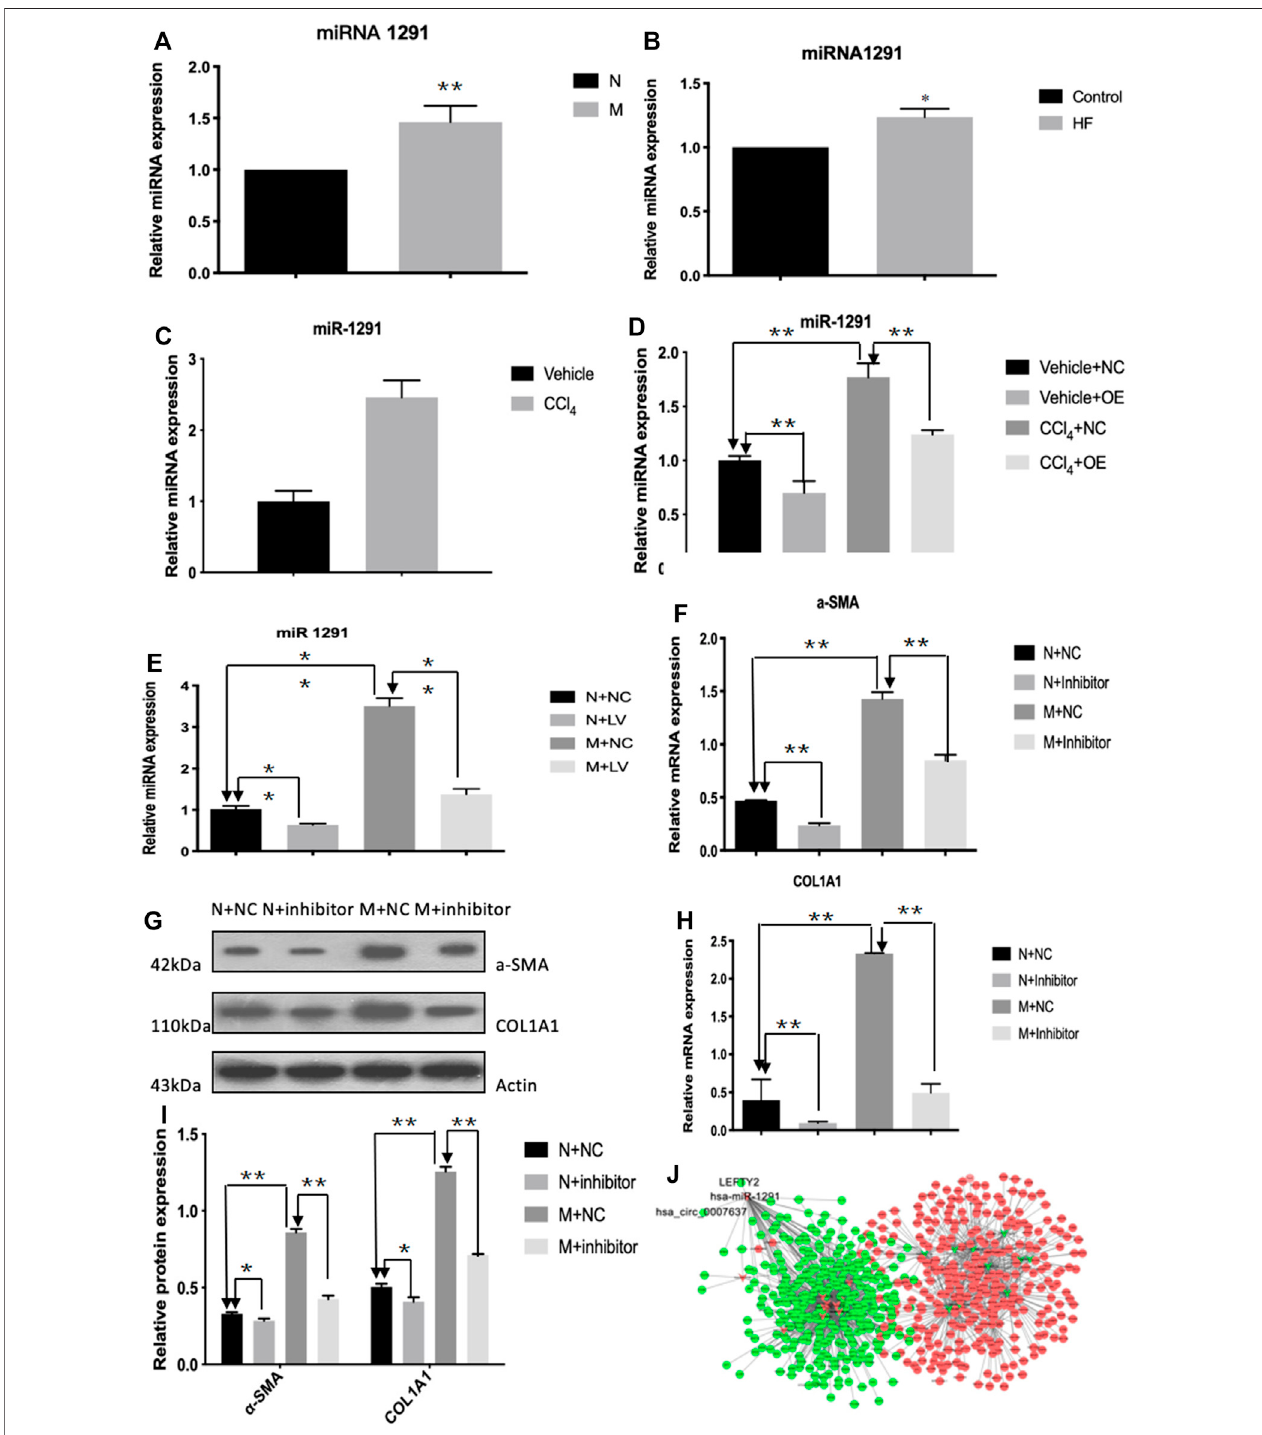
FIGURE 7 | CircCREBBP upregulates the expression of LEFTY2 by sponging hsa-miR-1291. The qRT-PCR results showed that the expression level of hsa-miR- 1291wereup-regulated inTGF- β 1-indcued LX-2cells, HFpatientsand mousetissues (A – C) .WhencircCREBBPexpression wasincreased,hsa-miR-1291 expression level was down-regulated (D,E) . α -SMA and Col1A1 protein and mRNA expression levels in LX-2 cells transfected with over-expressed hsa-miRNA-1291 were decreased (F – I) . An interaction network of circRNAs-miRNAs-mRNAs was established based on the negative regulatory relationship between differentially expressed miRNAs and their differentially expressed target circRNAs and mRNAs (J) .